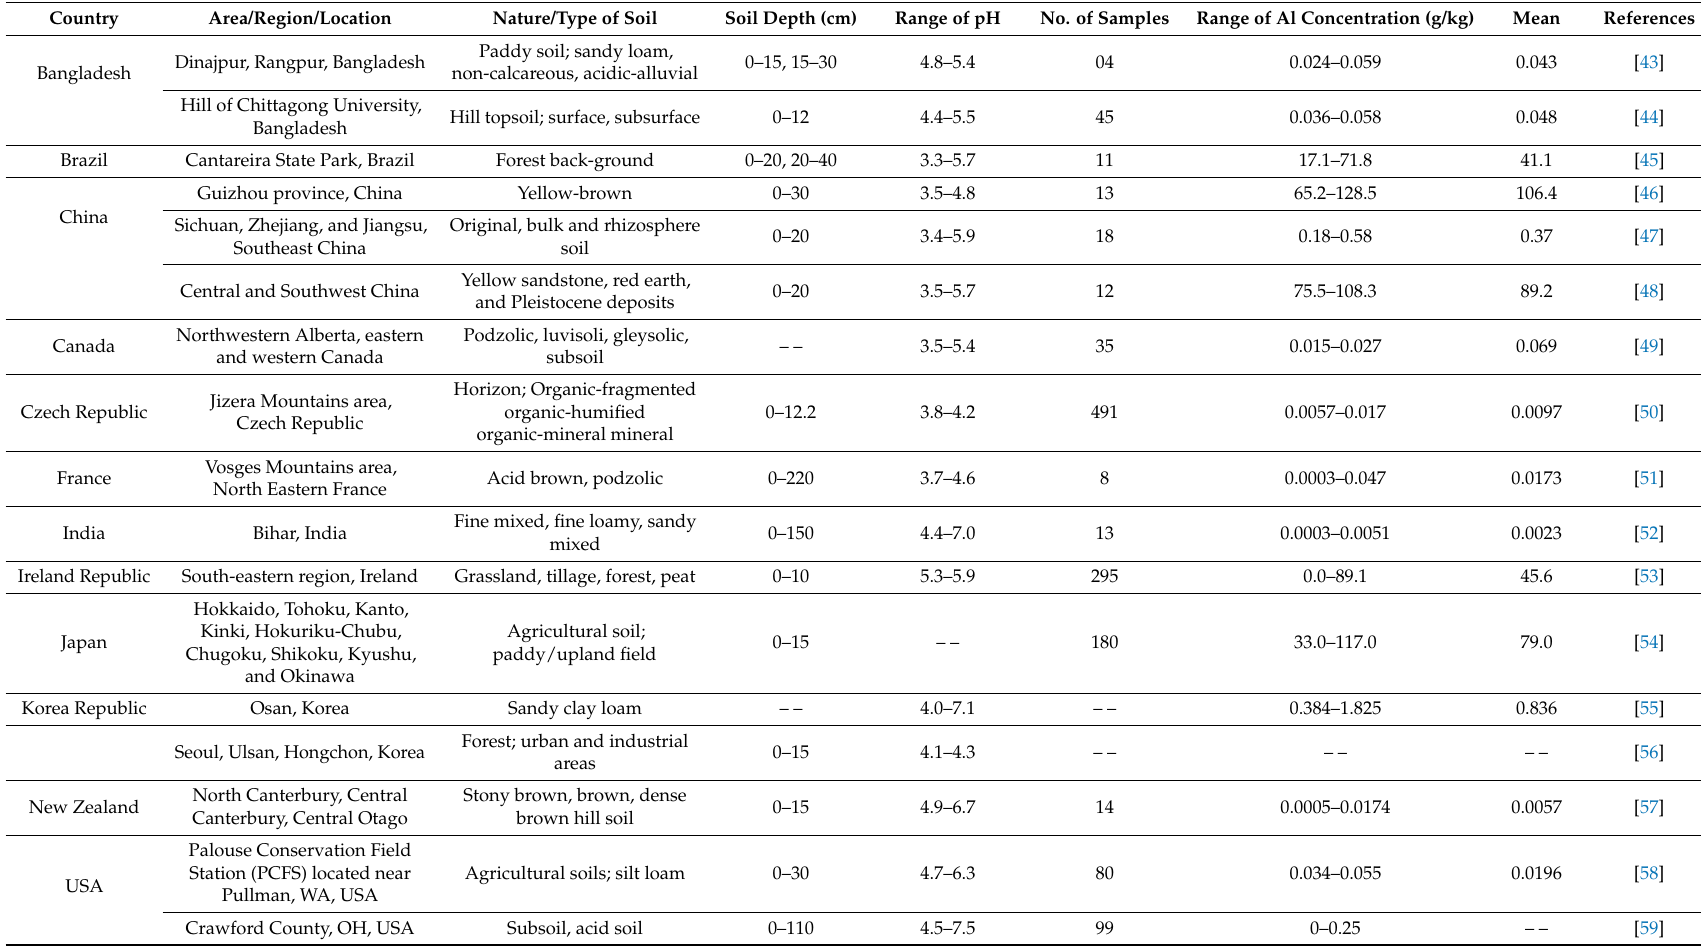
Table 1. Concentration of Al (g · kg − 1 ) in soil in different